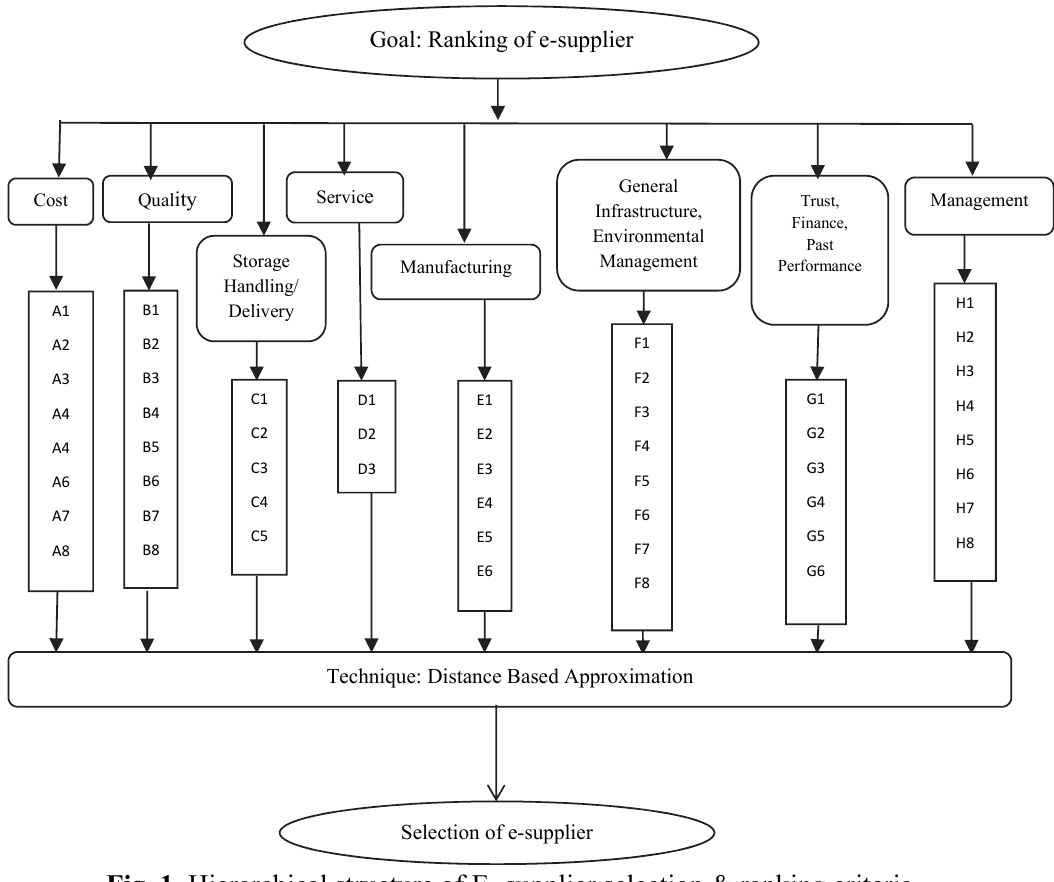
Fig. 1. Hierarchical structure of E- supplier selection & ranking